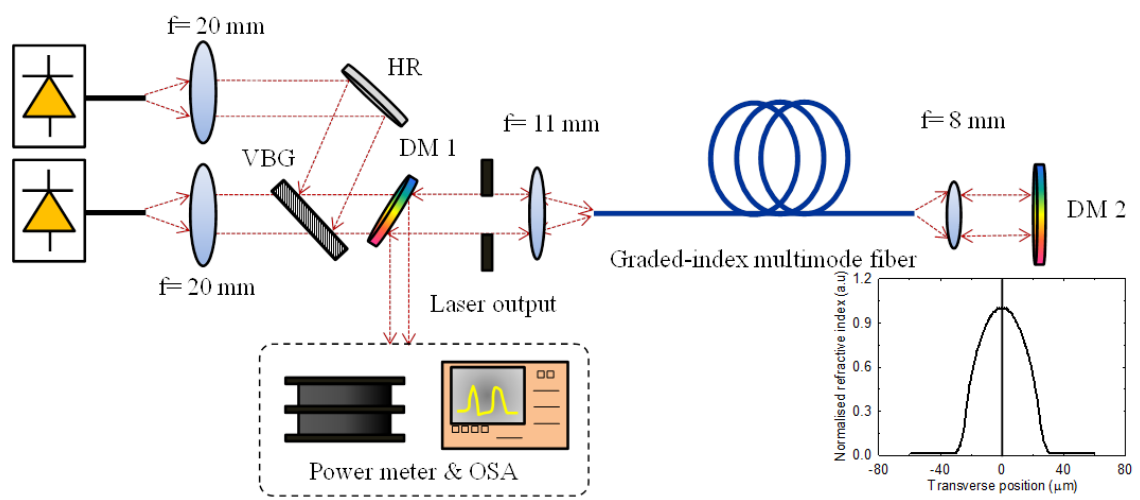
Figure 2. Experimental setup of the CW FRL with GRIN Raman gain fiber. VBG: volume Bragg grating; DM: dichroic mirror; HR: high reflection mirror. Inset: refractive index profile (RIP) through the center of the core of the GRIN MM